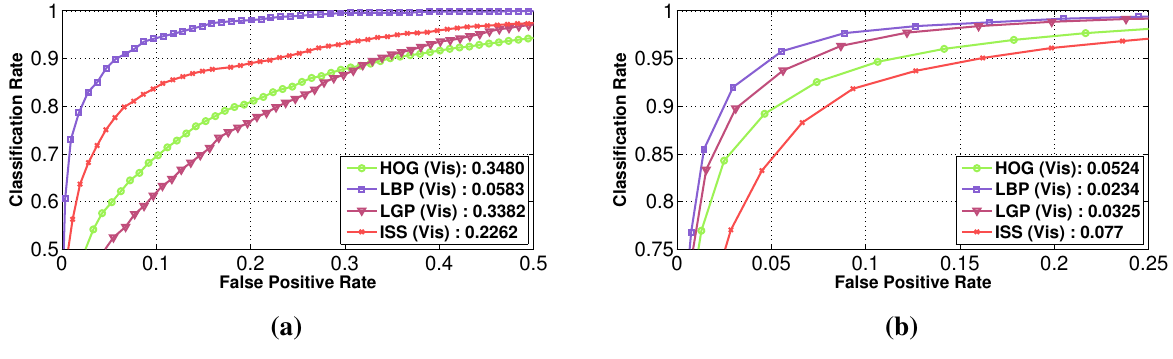
Figure 6. Feature performance comparison in the visible domain for the intensity modality on the datasets: ( a ) RIFIR; ( b ) Parma-Tetravision. The reference point is considered the false positive rate obtained for a classification rate of